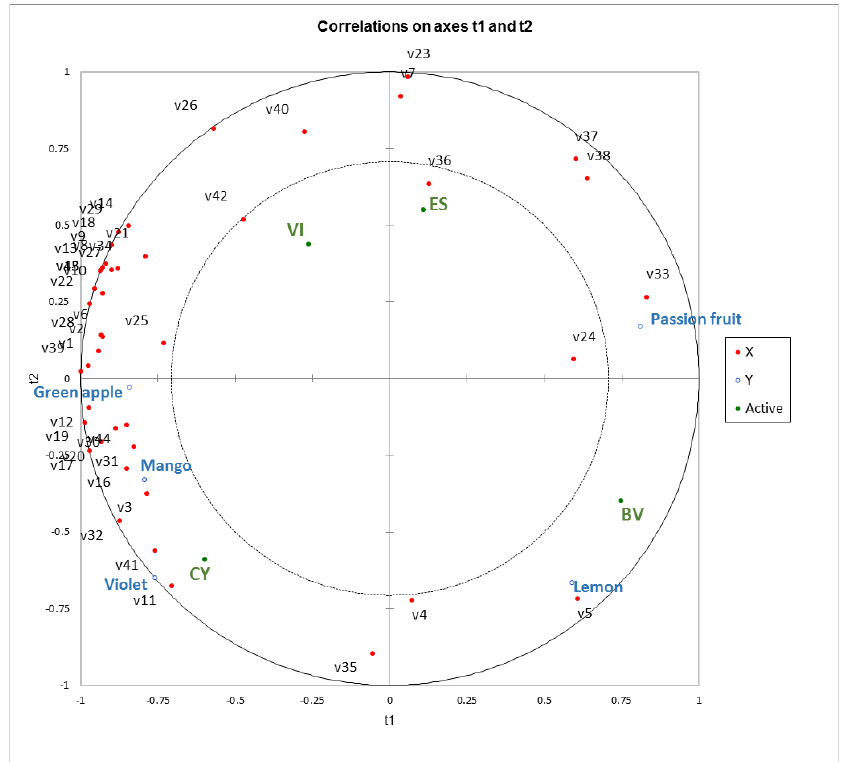
Figure 3. Partial least squares regression (PLSR) analysis using volatile compounds (OAV > 1 or esters OAV > 0.1, as listed in Table 4) and aroma descriptors (passion fruit, mango, green apple, lemon and floral with GM% > 20%) in passion fruit wine fermented by commercial yeast strain ES488 (ES), BV818 (BV), VIC (VI) and CY3079